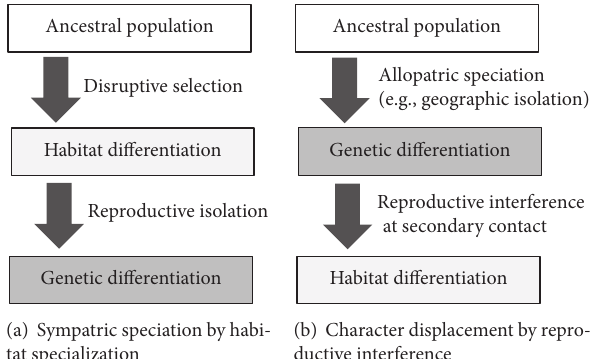
Figure 1: Two models of ecological specialization and niche dif- ferentiation in sibling lacewing species. (a) Sympatric speciation model. Disruptive selection within an ancestral population (i.e., ecological adaptation to different habitats) drives reproductive isolation, which leads to genetic differentiation and, subsequently, complete speciation. (b) Reproductive interference model. Repro- ductive interference drives habitat differentiation between the two species when secondary contact occurs after allopatric